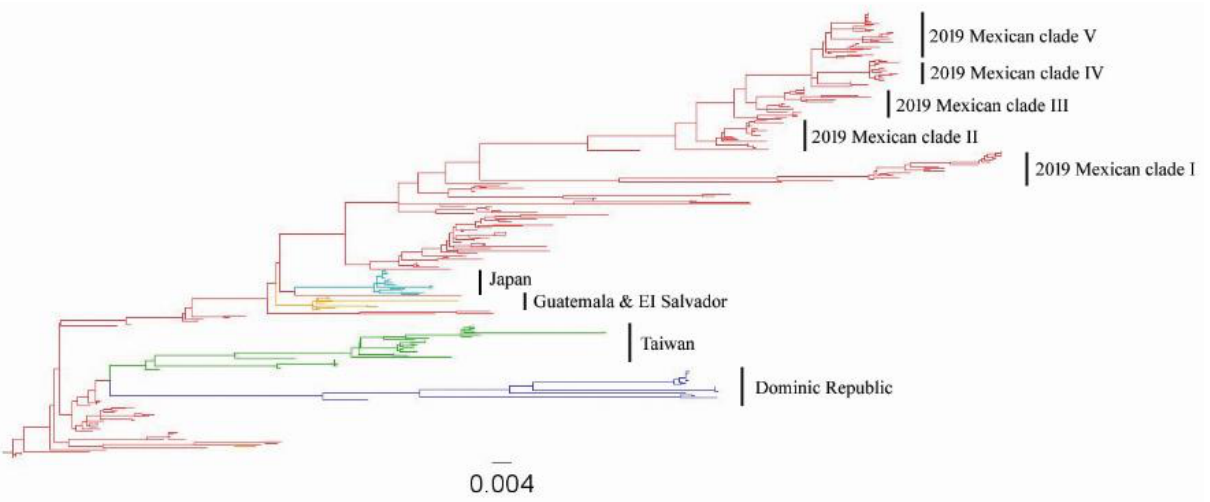
Figure 3. Estimate of reassortment network. Eight segment trees were embedded within the networks using CoalRe. Network edges are colored by segments carried.